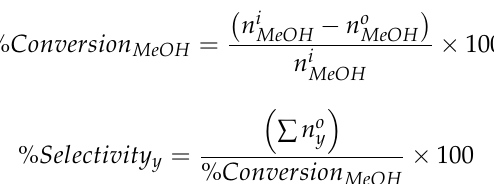
Figure S3: Nitrogen adsorption isotherms for zeolites synthesized with TPAOH and lignin (LZSM-5) for durations of 4, 8, 12, 16, 20, and 24